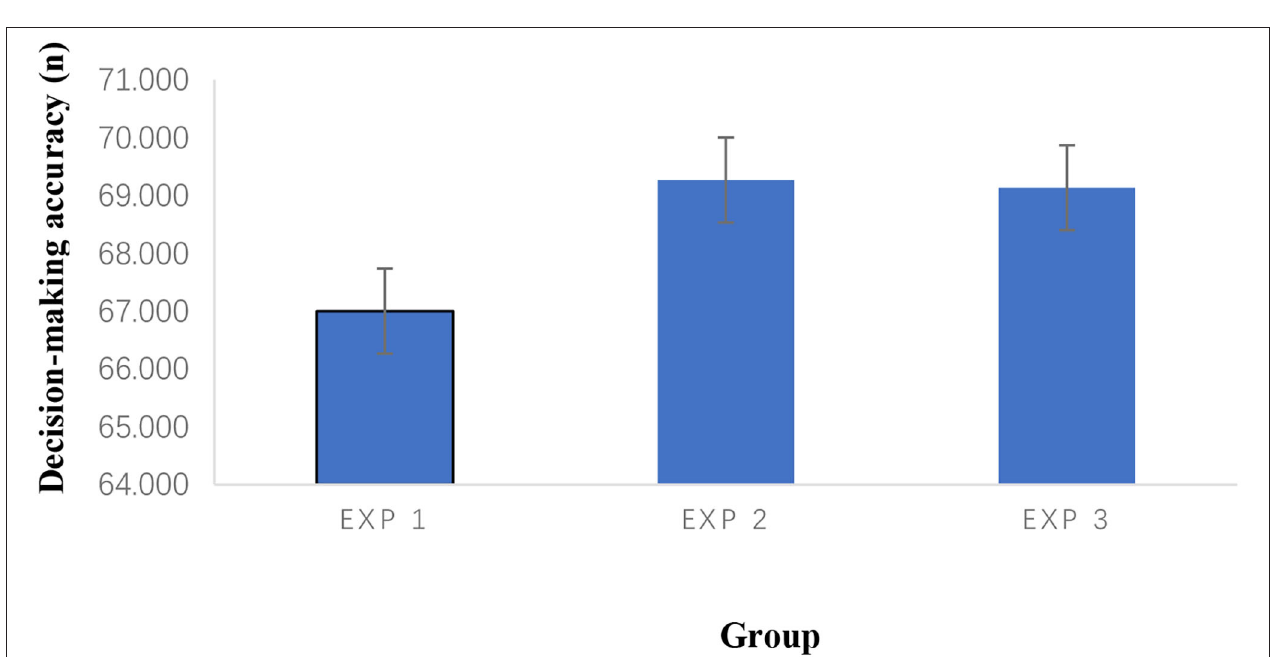
FIGURE 5 | The mean of accuracy at